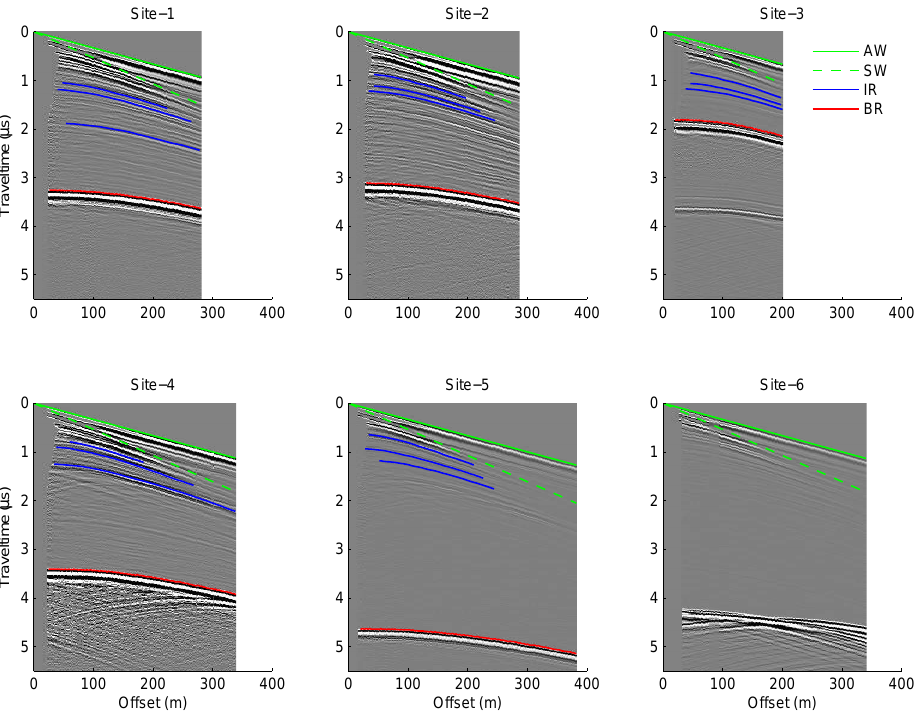
Figure 3. Wide-angle radar data showing air waves (AW, green lines) and surface waves (SW, green dashed lines) with linearly increasing traveltime with offset, while traveltime increases hyperbolically with offset for internal (blue) and basal (red) reflectors. See Fig. 2 for locations of Sites 1–6. Site 6 was excluded from further analysis because the basal reflection is ambiguous (probably due to off-angle reflectors in the